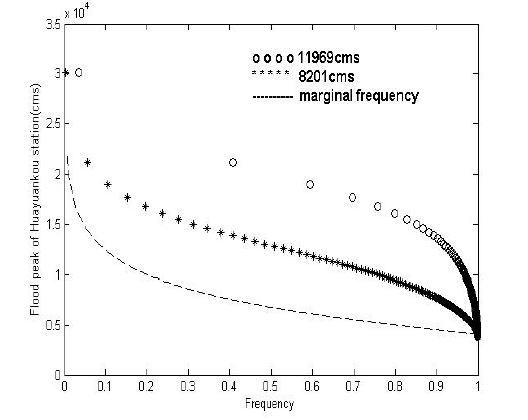
Fig. 6. Conditional frequency of Huayuankou station on the condition of different AMFM of Sanmenxia